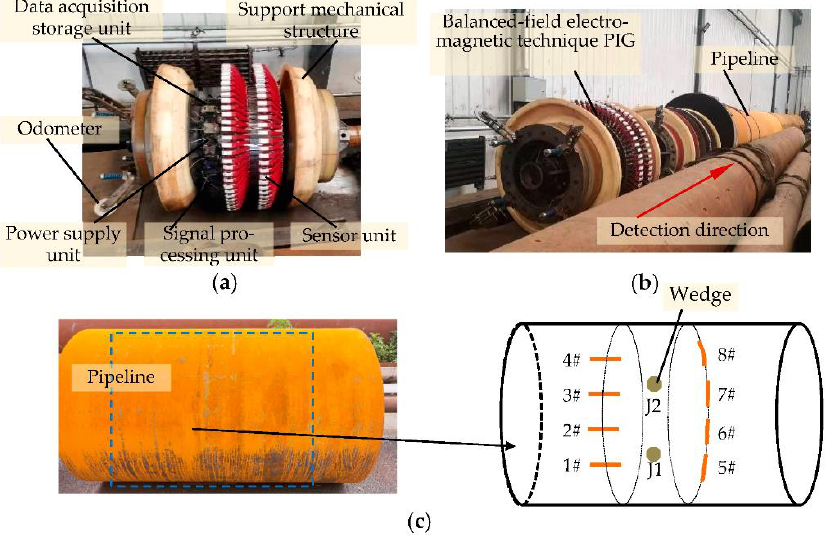
Figure 13. Pipeline field pulling test: ( a ) Balanced-field electromagnetic technique pipeline inspection gauge; ( b ) Pulling test site; ( c ) Schematic diagram of pipeline cracks distribution.